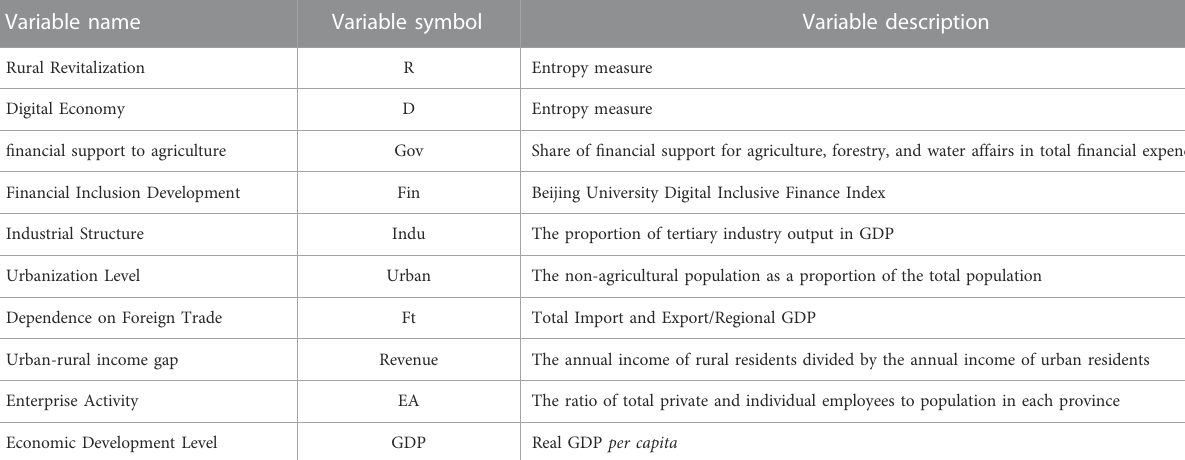
TABLE 5 Variable description.